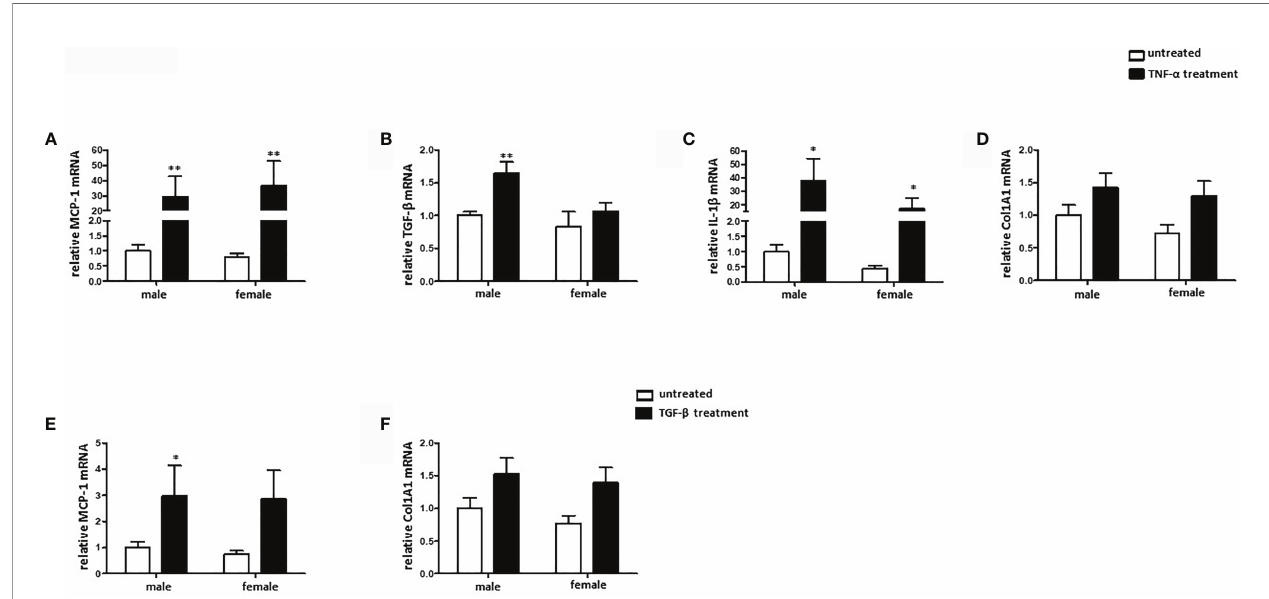
FIGURE 5 | TNF- a , but not TGF- b , induces pro- fi brotic phenotype in mouse cardiac fi broblasts. Real-time PCR analyses of (A) MCP-1, (B) TGF- b , (C) IL-1 b , and (D) Col1A1 performed with lysates from male and female mice cardiac fi broblasts treated with 20 ng/ml TNF- a for 24 h. Real-time PCR analyses of (E) MCP-1 and